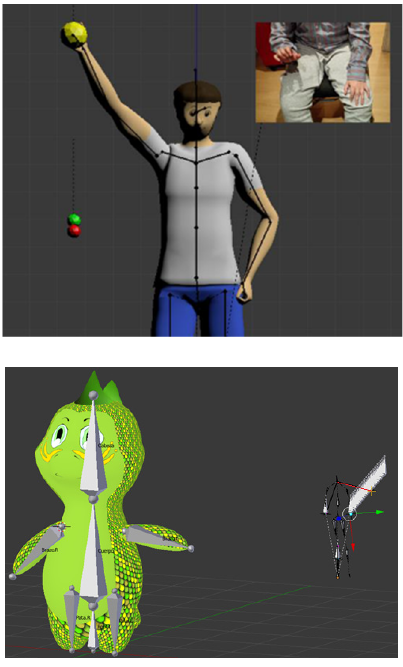
Fig. 5 sh ows screen shots of an intermediate sc ene where Phiby arrived climbing up the tree behind the wall. He has the possibility to choose the way through two different lakes (north & west), through chopping wood (east) or to the scene before (south) going down the tree again (no exercise required). Energy is on 85% and 7kg of wood have been gained. Phiby is constantly moving and the user controls the direction he should go with the right hand; the red arrow helps to see the direction. Once reaching the object (lake, trunk or tree), the corresponding exercise starts. The lower image shows the same scene with the apple eaten (energy 100%) and the map opened (by raising the left hand). The game is paused until the map is closed by raising the other hand. It can be also quit in this moment by raising the left hand again. The map in the figure shows that in that moment three cells have been visited.